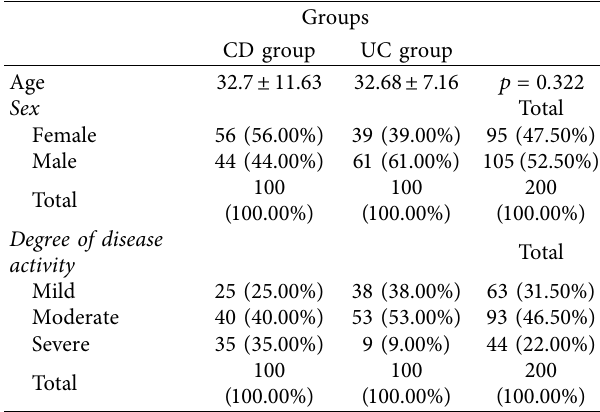
Table 1: Age, sex, and degree of disease activity in the CD group and the UC